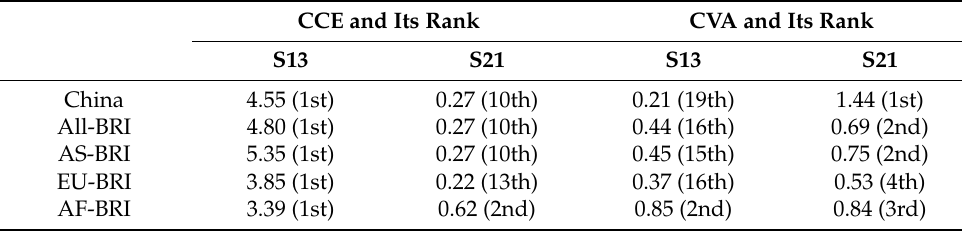
Table 4. Comparison of CCE and CVA between typical